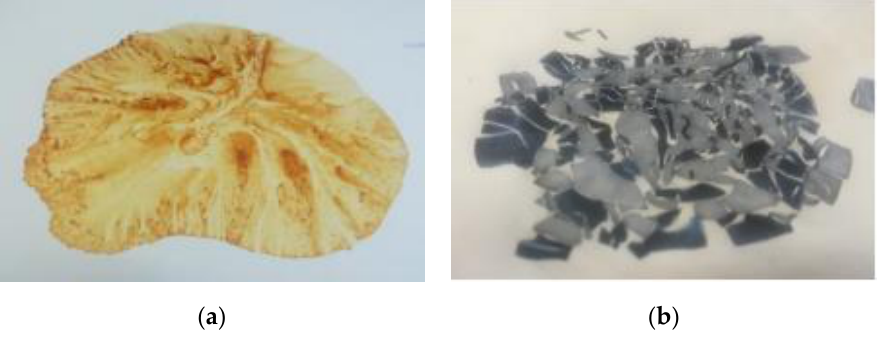
Figure 6. Thin film samples obtained from the 4 mm samples of PEI ( a ) and PPS ( b ) after the aging test.